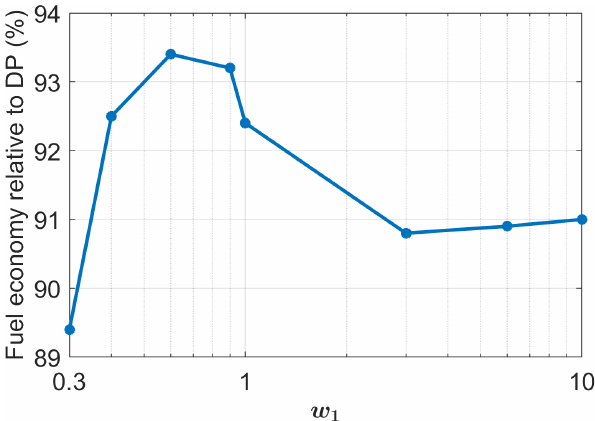
Figure 11. Fuel economy performance of a set of RL-based power-split PHEV EMS from a study by Lian et al. [73]. Each RL-based EMS uses a unique value of w 1 in the reward function, Equation (6). Fuel economies are all measured over the same drive cycle and compared to the DP